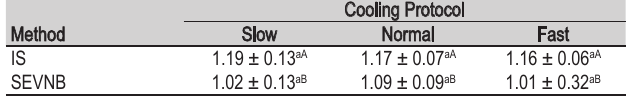
Table 2 - Comparison of IS and SEVNB methods according to the cooling protocol (mean ±